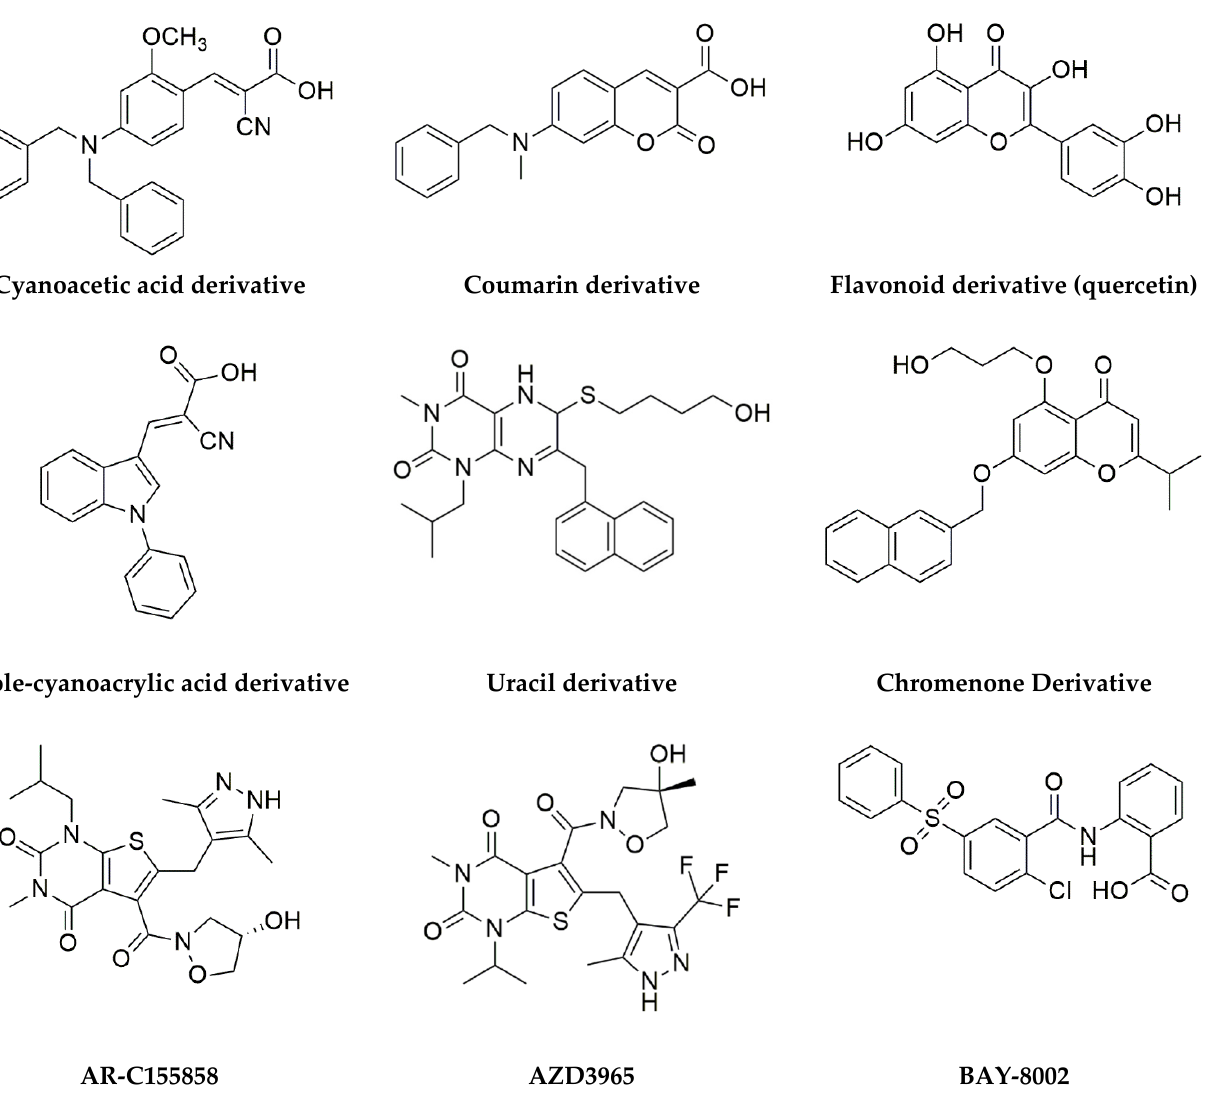
Figure 2. MCT1 inhibitors. Small molecules that belong to different chemical classes and for which MCT1 inhibitory activity has been described (reviewed in [18]). Cyanoacetic acid derivatives are dual MCT1/MCT4 inhibitors. AR-C155858 is a dual MCT1/MCT2 inhibitor, while AZD3965 partially inhibits MCT2 with a 6-fold lower affinity than MCT1. AZD3965 is the only compound that has entered the clinical trial phase.